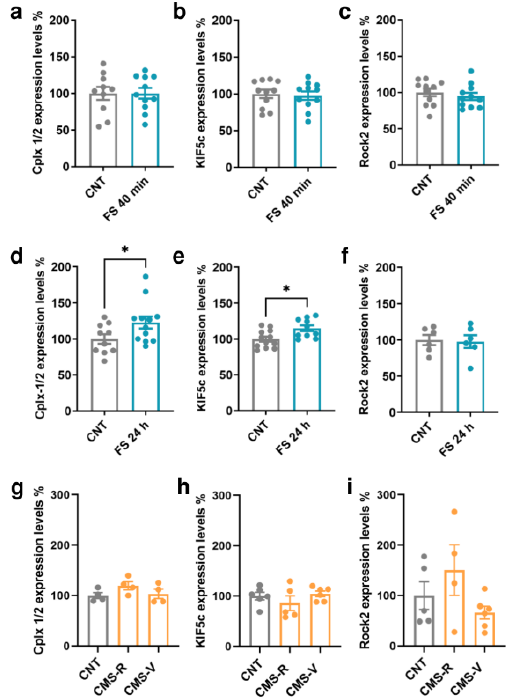
Figure 4. MiR-135a-5p target genes protein expression in the PFC of FS and CMS rats. ( a ) Cplx 1/2, ( b ) Kif5c, and ( c ) Rock2 protein expression in the PFC of FS rats immediately after stress. ( d ) Cplx 1/2, ( e ) Kif5c, and ( f ) Rock2 protein expression in the PFC of FS rats 24 h after the beginning of stress. Student’s t -test, * p < 0.05; N = 6 – 12 (CNT), 6 – 12 (FS). ( g ) Cplx 1/2, ( h ) Kif5c, and ( i ) Rock2 protein expression in the PFC of CMS rats. ( g ) and ( i ): Kruskal –Wallis test, Dunn’s post hoc test; N = 4 – 5 (CNT), 4 (CMS-R), 4 – 6 (CMS-V). ( h ): one- way ANOVA, Tukey’s post hoc test; N = 5 (CNT), 5 (CMS-R), 5 (CMS-V).